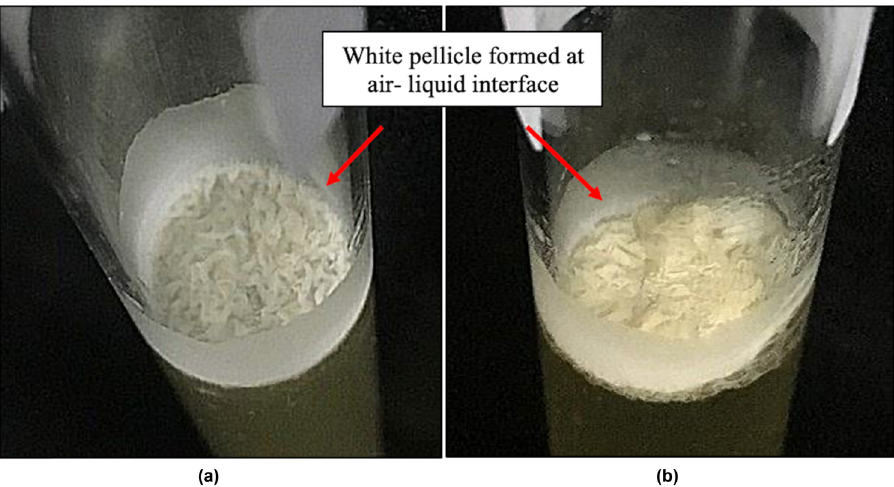
Figure 2: Observation of white pellicles formed on the air – liquid surface as initial indicator of cellulose production: ( a ) fl oating pellicles formed by isolate USM - YBP1 and ( b ) membranous pellicles formed by isolate USM - YBP2.